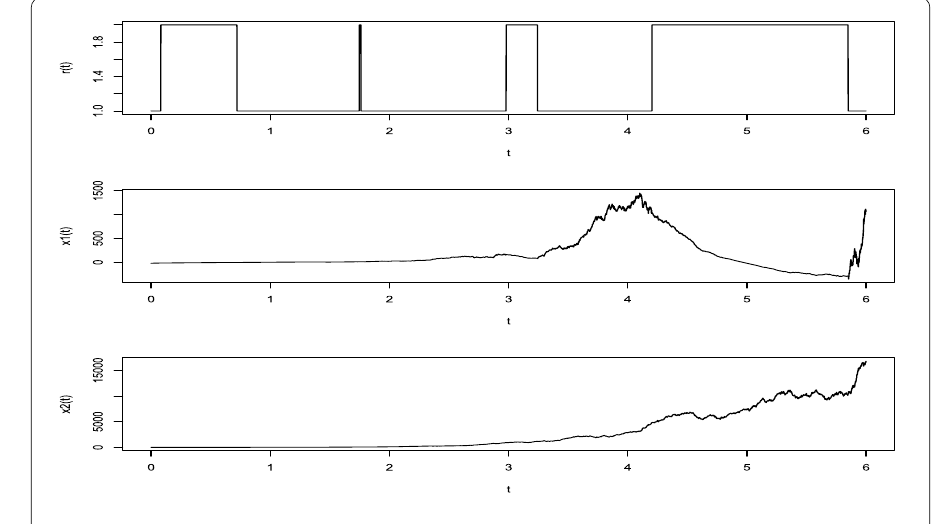
Figure 1 Computer simulation of the paths of r ( t ), x 1 ( t ) and x 2 ( t ) for the original system of system (4.1) using the Euler-Maruyama method with step size 10 –6 , delay upper bound h = 0.1 and initial values r (0) = 1, x 10 = –20 and x 20 = 10.